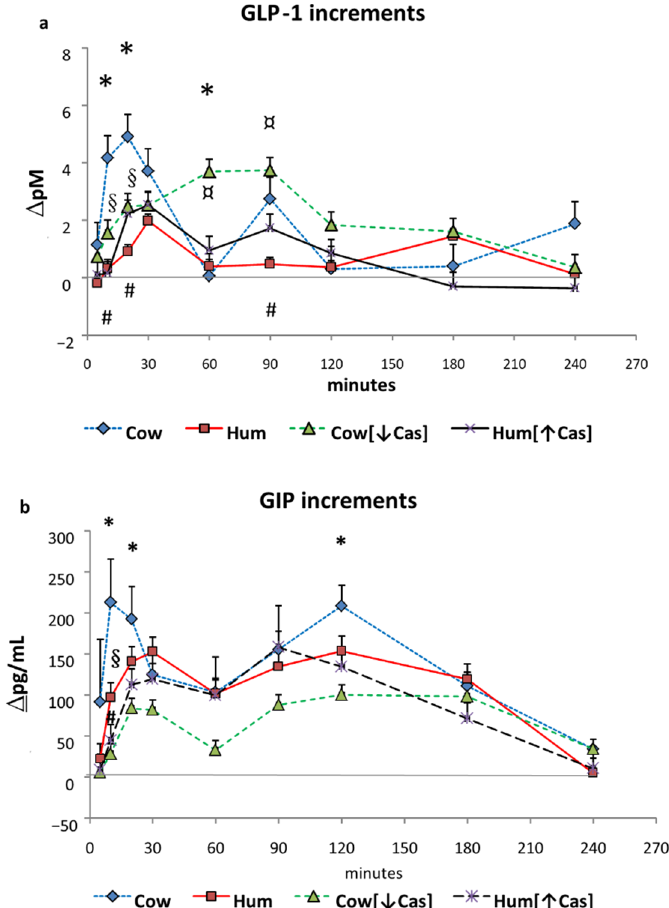
Figure 3. GLP-1 and GIP. Abbreviations: GIP: glucose-inhibitory-polypeptide; GLP-1: glucagon-like polypeptide-1; Hum: human; Cow [ ↓ Cas]: low-casein cow milk; Hum [ ↑ Cas]: high-casein human milk. ( a ): Increments vs. baseline values of plasma GLP-1 concentrations (expressed as ∆ pM/mL) following milk administration over the 240 min study period. Data are means ± SEM. The symbols indicate the statistical difference (by two-way ANOVA the Fisher’s LSD test): (*) at 10′, 20′ and at 60′ between Cow [ n = 7] and Cow[ ↓ Cas] milk ( n = 9) ( p = 0.025, p < 0.04, and p < 0.002, respectively); [#] at 10′, 20′ and 90′ between Cow [ n = 7], and Hum [ n =7] milk ( p = 0.002, p < 0.0015, p = 0.066); [§] at 10′ and 20′ between Cow [ n = 7] and Hum[ ↑ Cas] [ n = 6] milk ( p < 0.002 and p < 0.04, respectively); and finally [¤] between Hum [ n = 7] and Cow[ ↓ Cas] milk [ n = 9] at 60′ and 90′ ( p < 0.005 at both time points) (by two-way ANOVA the Fisher’s LSD test). ( b ): Increments vs. baseline values of plasma GIP concentrations (expressed as ∆ pM/mL) following milk administration over the 240 min study period. Data are means ± SEM. The symbols indicate the levels of statistical difference (by two-way ANOVA the Fisher’s LSD test): (*) at 10′, 20′ and 120′ between Cow [ n = 7] and the Cow[ ↓ Cas] milk [ n = 9] ( p < 0.0001, p = 0.015 and p < 0.02 respectively); at 10′ between the Cow [ n = 7] and either [§] the Hum [ n = 7] ( p < 0.02) or the [#] Hum[ ↑ Cas] [ n = 6] ( p = 0.001) milk.